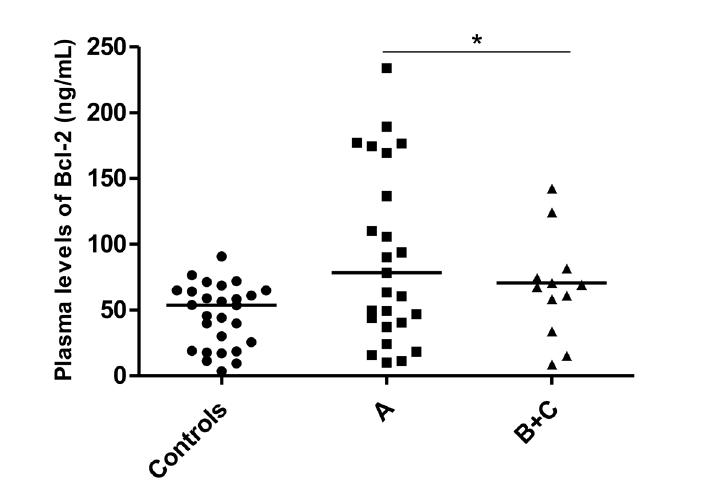
FIGURE 5 - Plasma levels of Bcl-2 in the Controls, Binet A (A) and Binet B+C (B+C) groups. *p < 0.001: A versus B+C. No significant difference was found when comparing Control and Binet A and Binet B+C. Data was presented as median values generated by ANOVA, followed by the Kruskal-Wallis